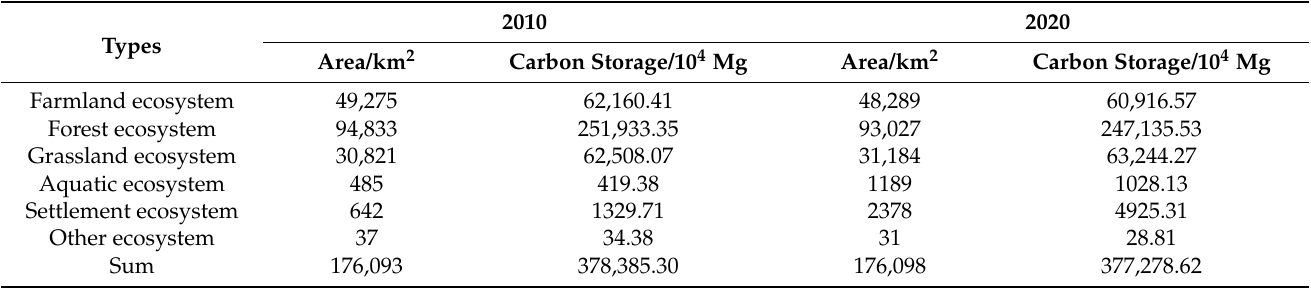
Table 5. Terrestrial ecosystem area and carbon storage in Guizhou Province from 2010 to